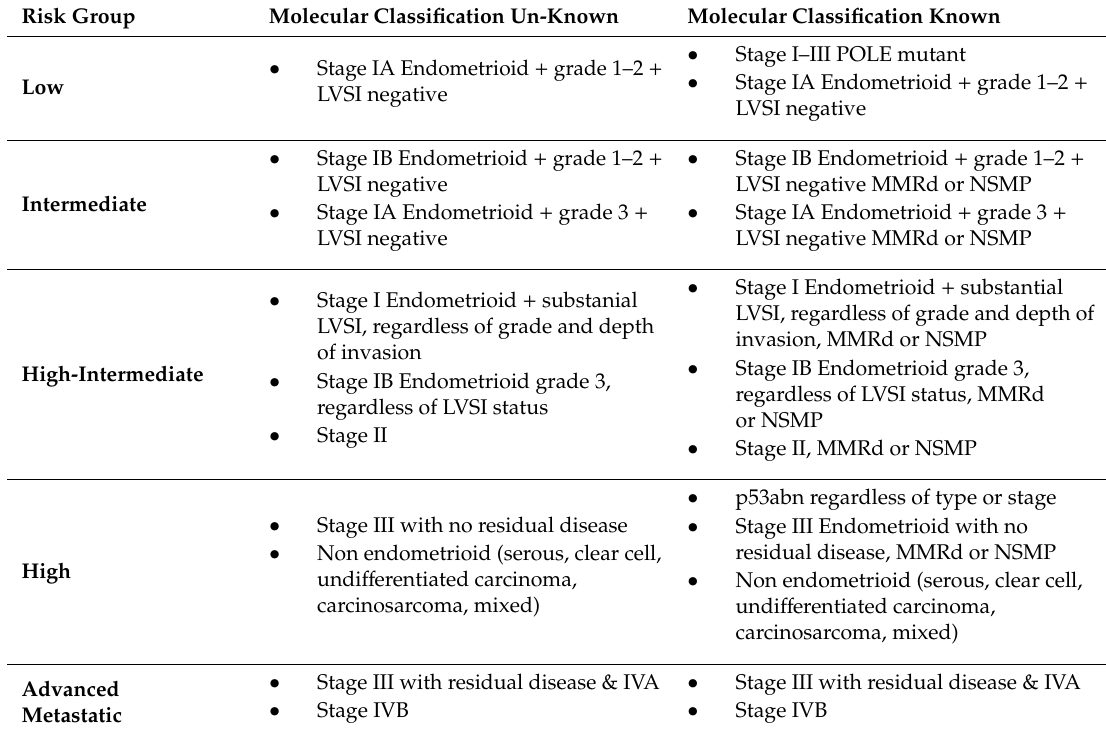
Table1. UpcomingESGOandESTROrecommendationsonriskstratificationaftergenomicclassification (right) compared to clinical risk stratification